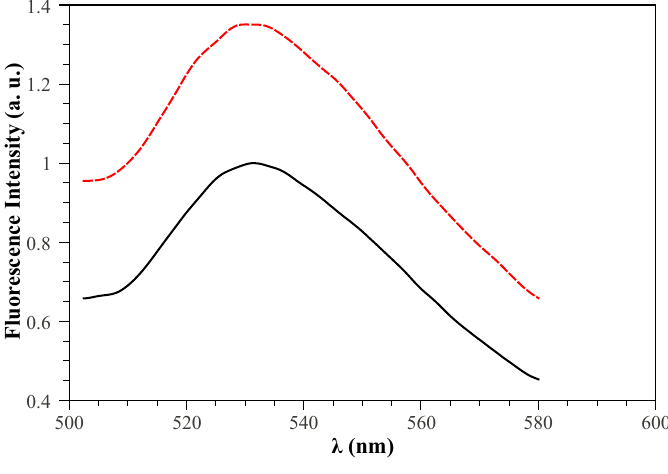
Figure 6. Immobilized GOD fluorescence emission spectrum in the FAD region = 405 nm) without (black curve) and with (red curve) 2 mM glucose concentration. ( (cid:21) exc